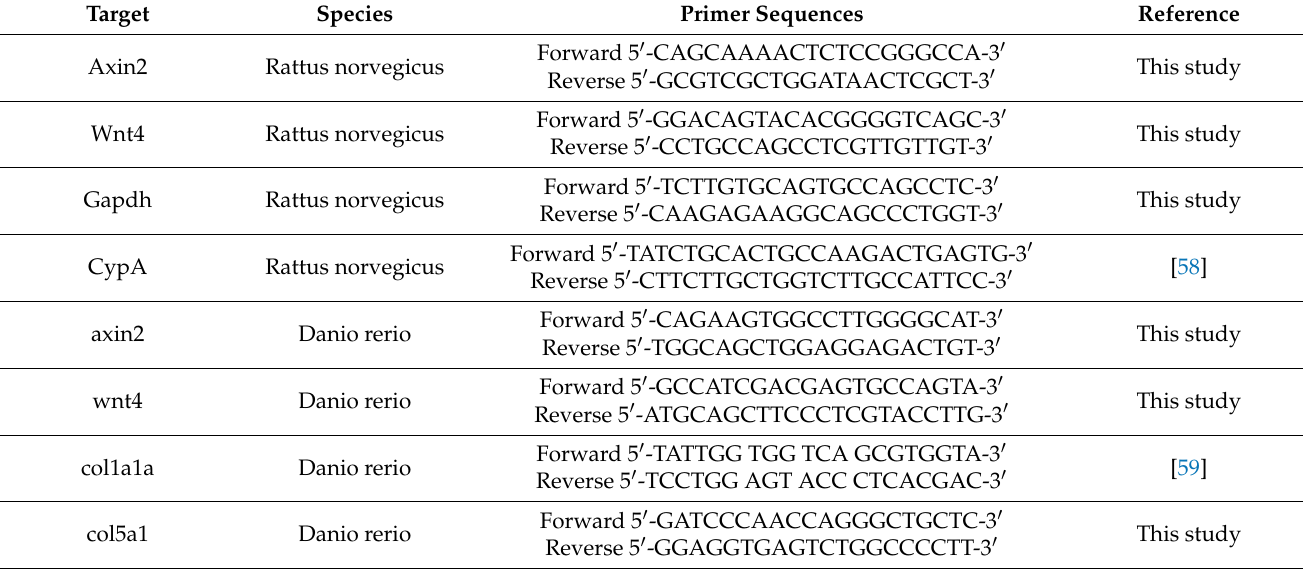
Table 3. List of primers used in the